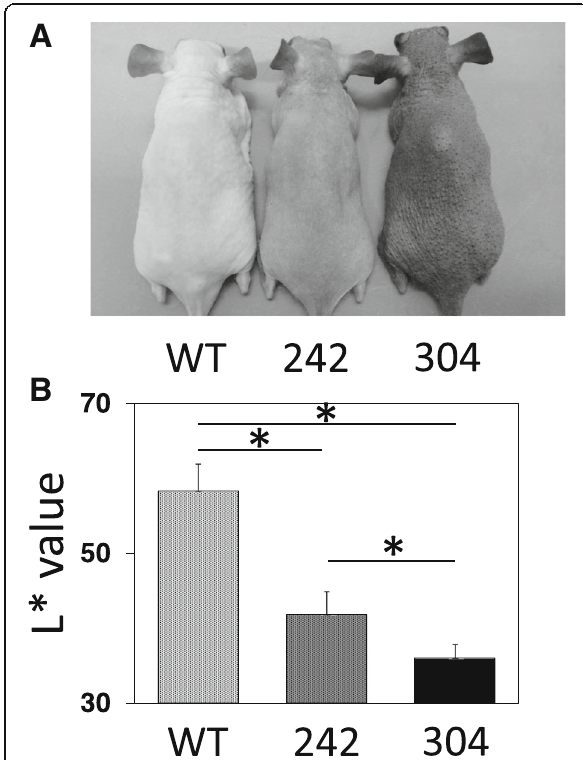
Fig. 1 Hairless mice with different levels of skin pigmentation. a Photographs of dorsal skin from wild-type mice (WT) and HL-RET- mice of lines 242 (242) and 304 (304) at 4 months of age are shown. b The skin pigmentation levels (means ± SD, n = 11) in dorsal skin ( L * values) are presented. Significant differences (** p < 0.01) were